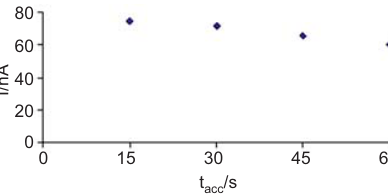
Figure 5 Effect of the accumulation time (t adsorptive peak current response for 300.00 ng/ml EZE in [K (0.1 m ) – Na